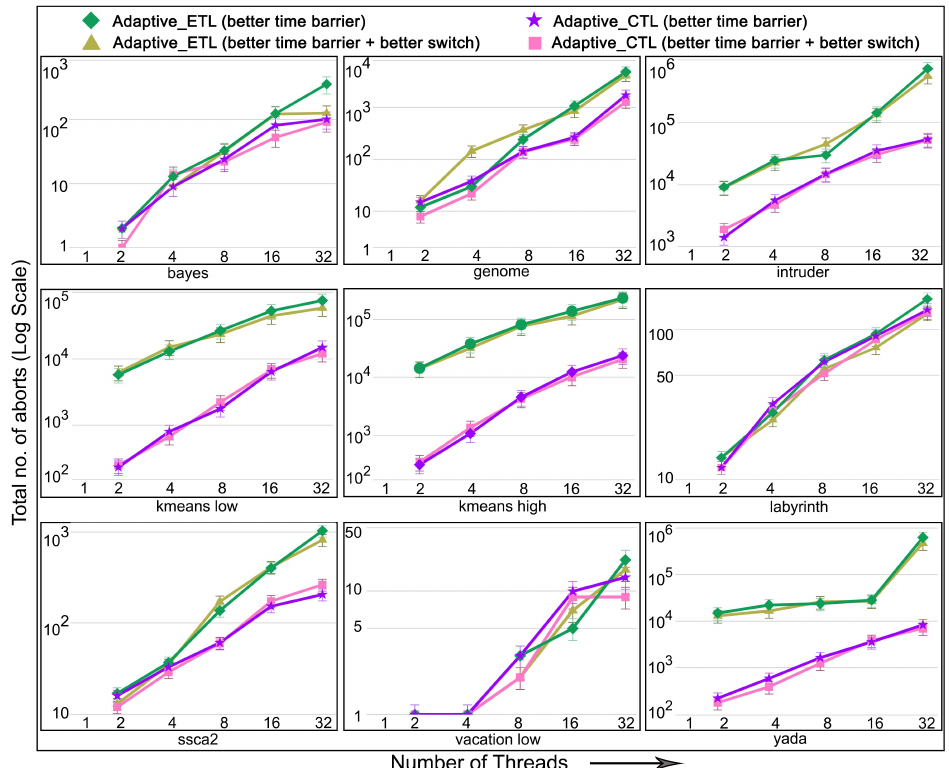
Figure 26. Aborts in STAMP benchmarks using better barrier and better switch in non-persistent TM.